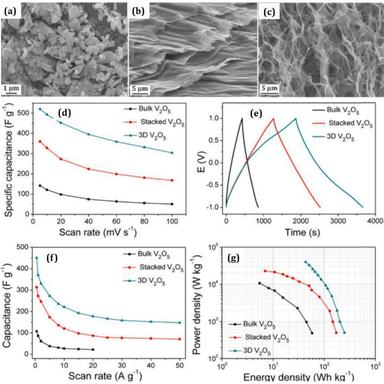
FESEM images: (a) commercially available bulk, (b) staked films, and (c) 3D architecture constructed from. Electrochemical performance of 3D V2O5, staked films, and bulk for SCs: (d) CV curves, (e) GCD curves, (f) rate capability Graphs; and (g) Regon Plots. Reproduced from Ref. ..